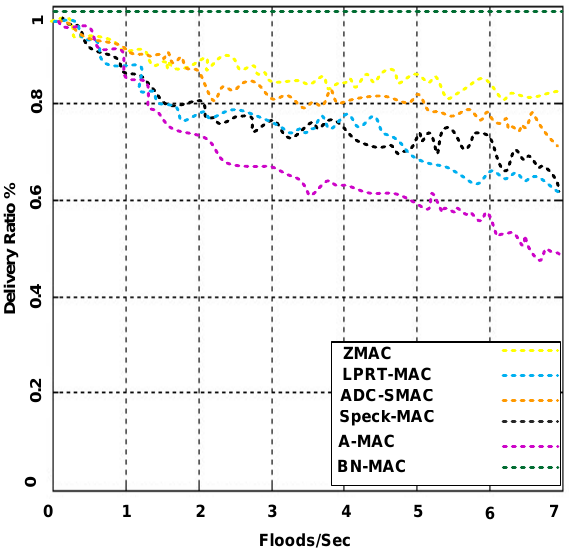
Figure 22. Delivery ratio under broadcast flood